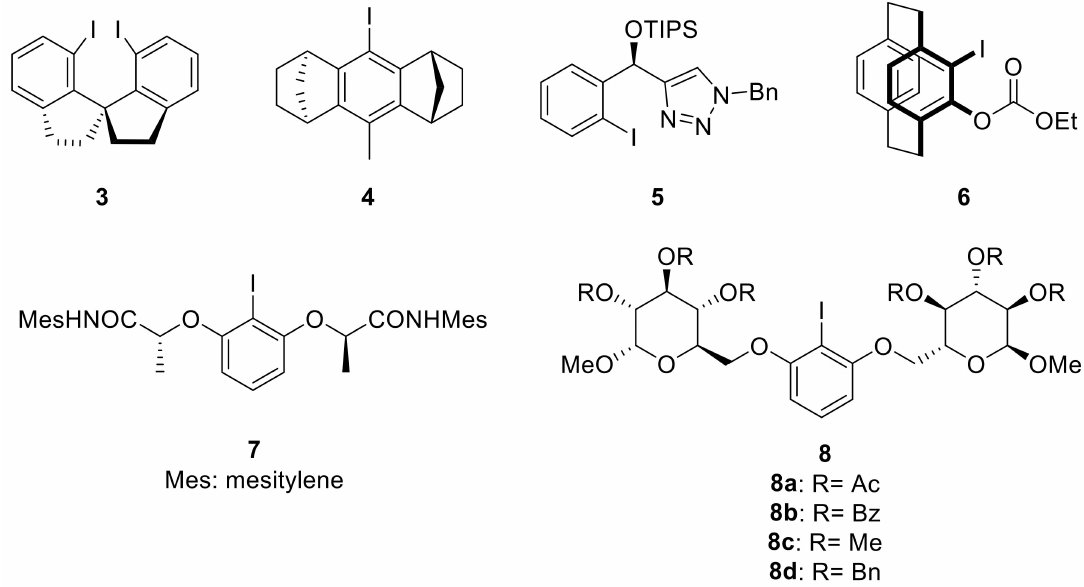
Figure 1. Some examples of chiral iodoarene catalysts described in the literature